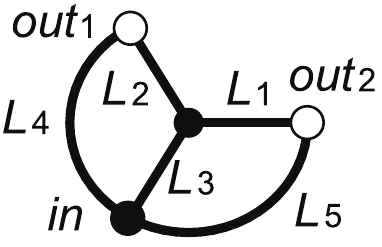
Figure 7. The simple network used for stability analysis. The link lengths were set as L 1 ~ L 2 ~ L 3 ~ 1 : 0 and L 4 ~ L 5 ~ 2 : 0 so that any path length from in to out 1,2 is 2.